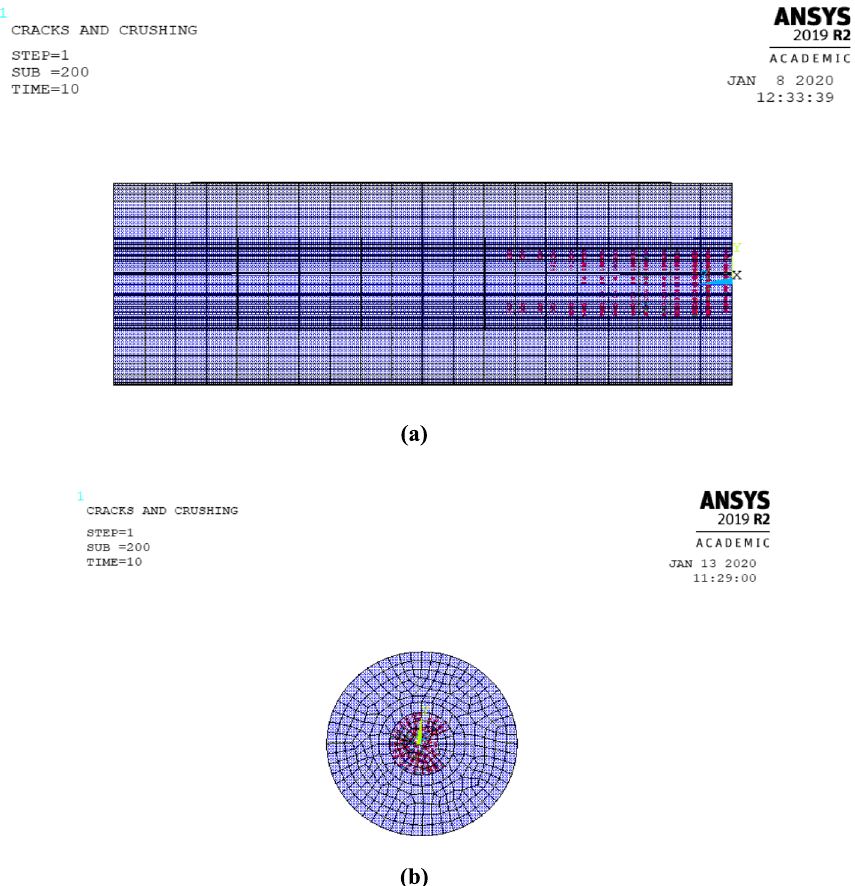
Fig. 17 a Crack pattern in model for dynamic loading. b Crack pattern in model for dynamic loading